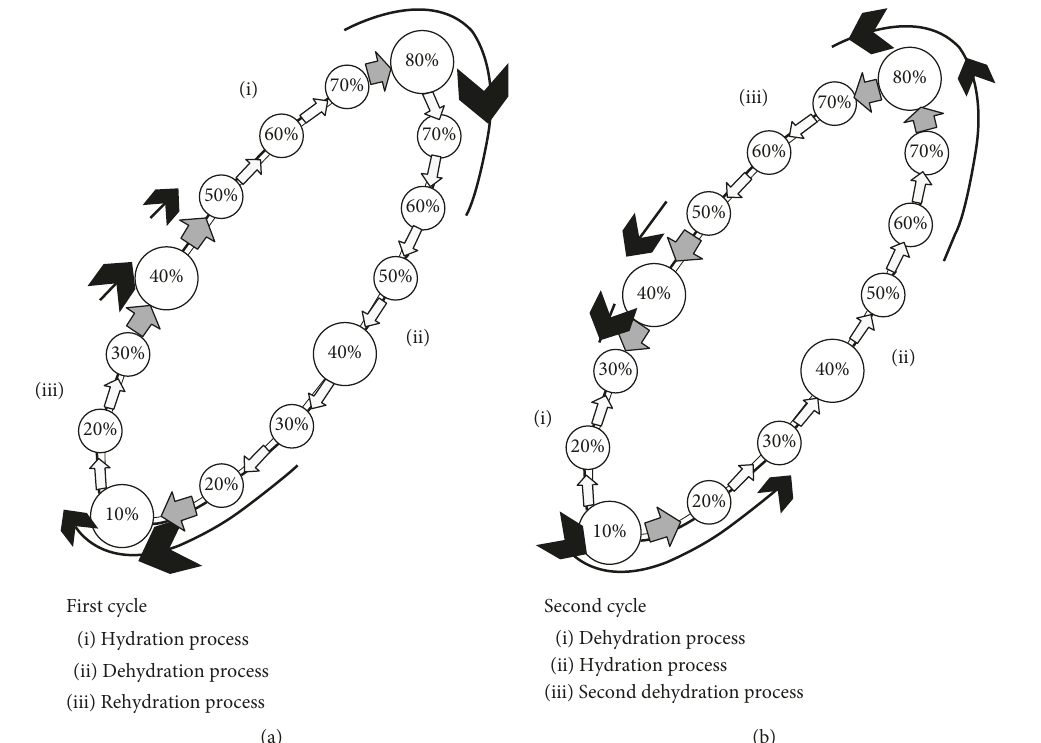
Figure 1: Sequence variation of the RH% during different hydration-dehydration